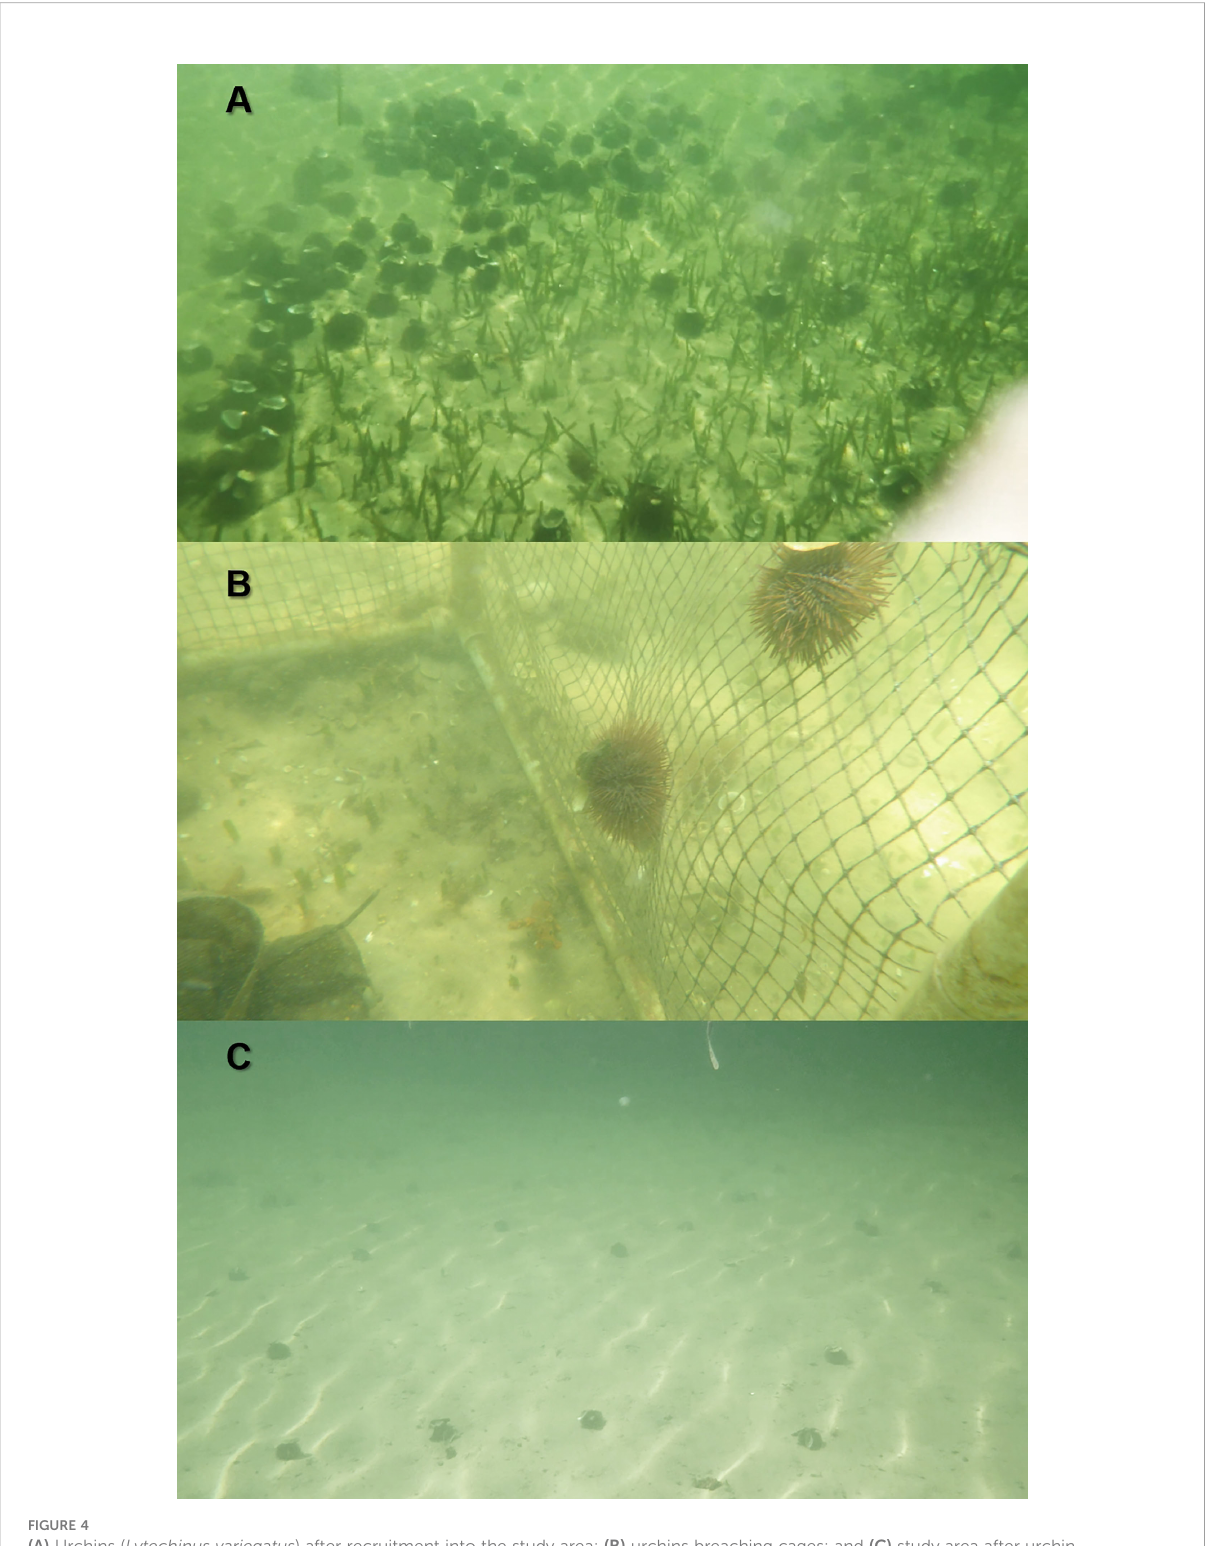
FIGURE 4 (A) Urchins ( Lytechinus variegatus ) after recruitment into the study area; (B) urchins breaching cages; and (C) study area after urchin